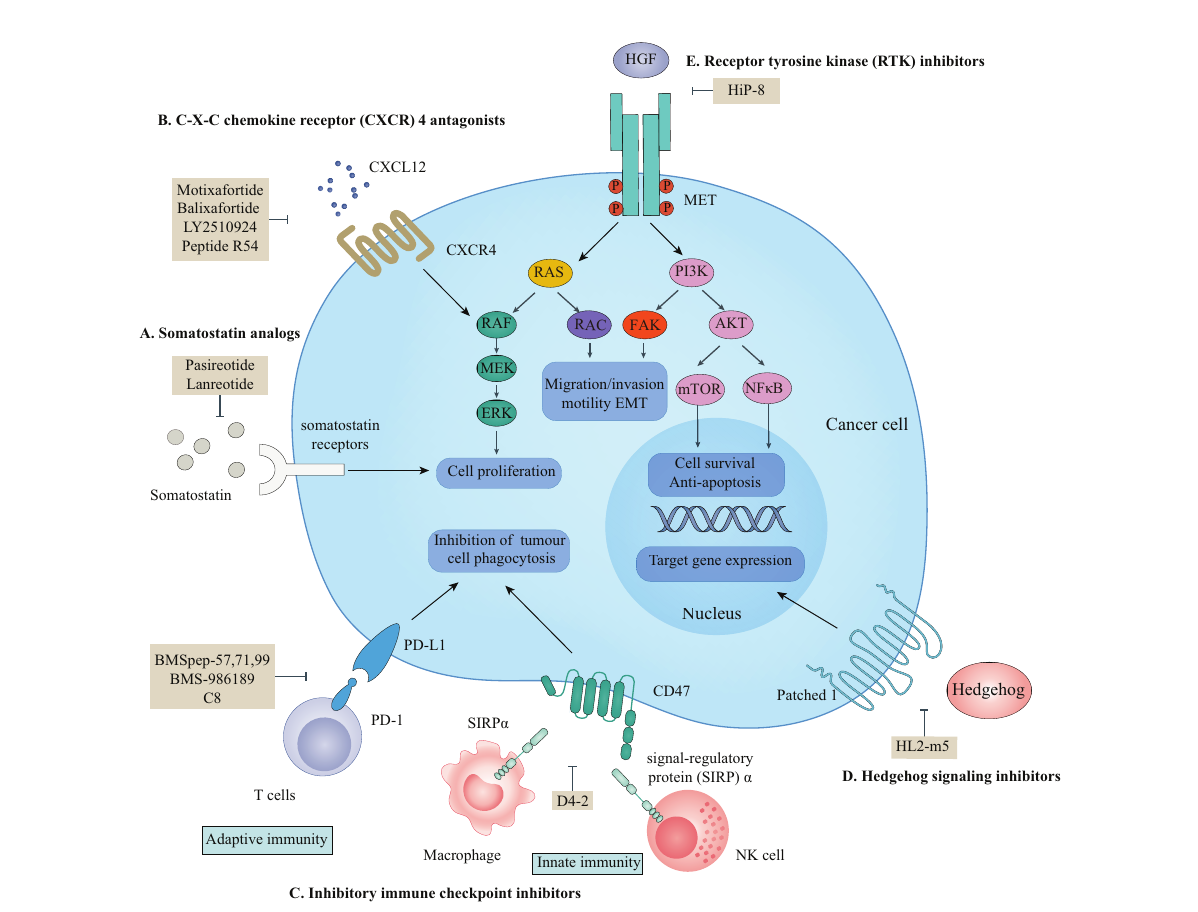
FIGURE 1 Macrocyclic peptides targeting extracellular protein-protein interactions. This scheme shows macrocyclic peptides-targeted extracellular proteins, the related signaling pathways, and their cellular functions. (A) somatostatin analogs. Lanreotide and pasireotide are somatostatin analogs. They can inhibit the activation of somatostatin receptors by endogenous somatostatin to inhibit cell proliferation. (B) C-X-C chemokine receptor (CXCR4) antagonists. Motixafortide, balixfortide, LY2510924, and Pep R54 can inhibit the interaction between CXCR4 and CXCL12, which is essential for cancer cell proliferation. (C) Inhibitory immune checkpoint inhibitors. BMSpep-57,77,99, BMS-986189, and C8 can inhibit the interaction between programmed cell death protein 1 (PD-1) and programmed cell death ligand 1 (PD-L1), which negatively modulate the adaptive immune systems. D4-2 can inhibit the interaction between CD47 and signal-regulatory protein (SIRP) a , which releases an inhibitory ‘ do not eat me ’ signal to lead to cancer cell evasion of immune detection and clearance. The PD-1/PD-L1 axis and CD47/SIRP a axis are critical for cancer immunotherapy. (D) Hedgehog (HH) signaling protein inhibitors. HL2-m5 can inhibit the activation of the HH pathway, which regulates target gene expression. (E) Receptor tyrosine kinase (RTK) inhibitors. HiP-8 can inhibit the hepatocyte growth factor (HGF)-mesenchymal-epithelial transition tyrosine kinase receptor (MET) interaction which is critical for cancer cell proliferation, migration, and